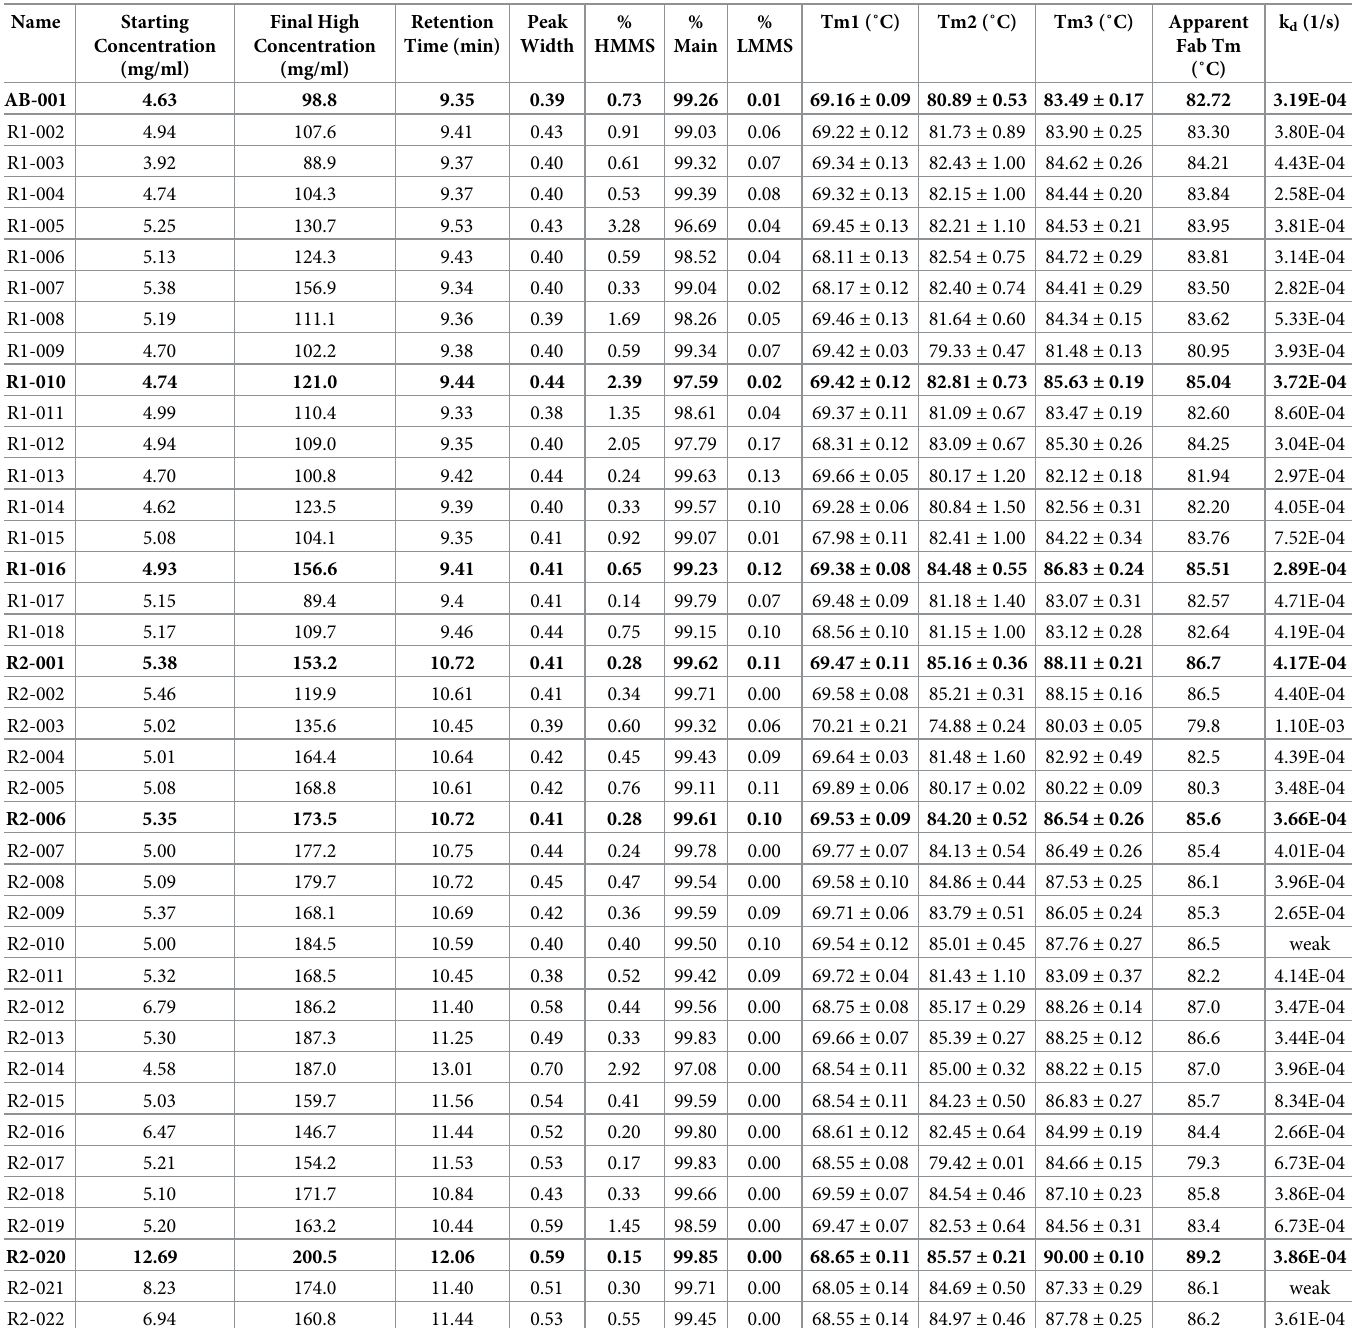
Table 2. Biophysical properties and off-rate screening of design mutants.